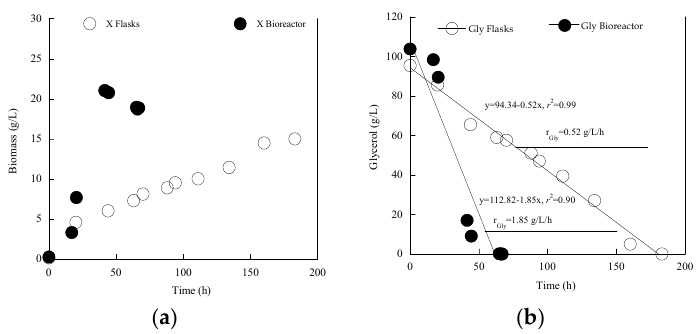
Figure 3. Kinetics of dry yeast cell mass production ( X , g/L) ( a ) and glycerol assimilation ( Gly , g/L) ( b ) in shake flask and batch bioreactor experiment of Yarrowia lipolytica LMBF Y-46 during growth on pure glycerol, at initial glycerol concentration ( Gly 0 ) ≈ 100 g/L under nitrogen-limited conditions. Culture conditions as in Tables 1 and 3. Each experimental point is the mean value of two independent determinations (SE ≤ 18%).